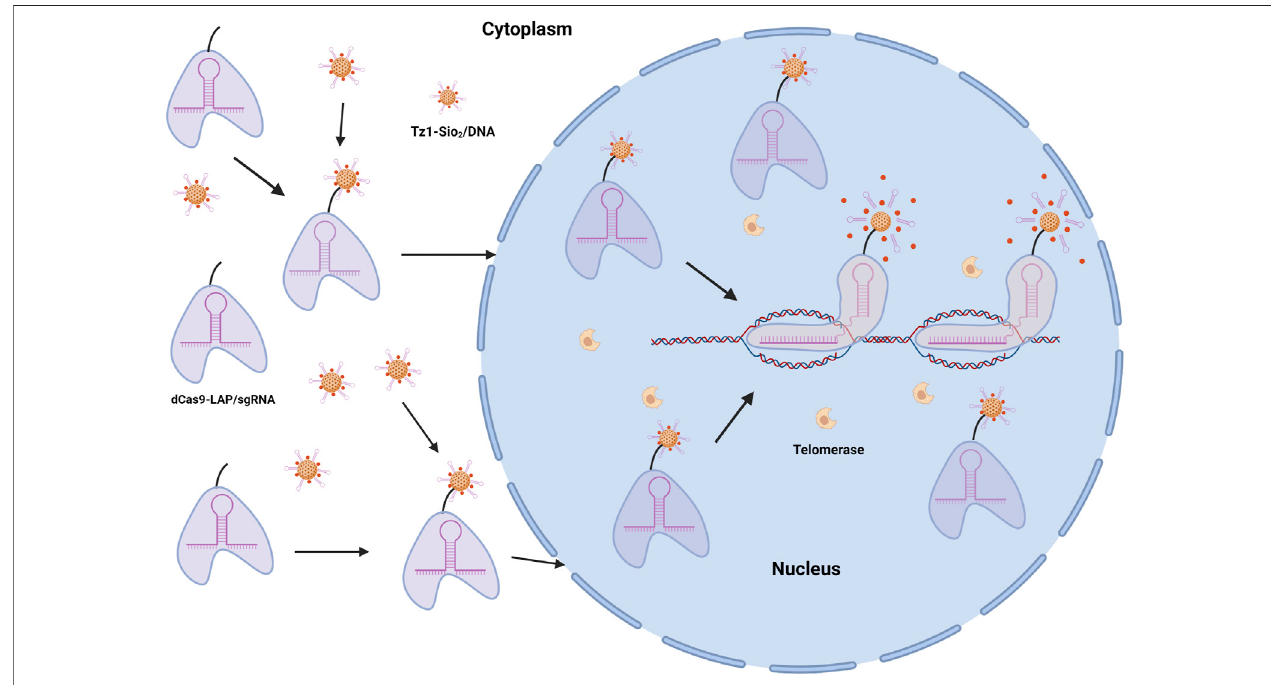
FIGURE 3 | dCas9-MSN/DOX/DNA drugs target cancer cell nucleus and release. DOX, the primary anticancer agent, is encapsulated in MSNs to produce the telomerase-responsive biogate (MSNs/DOX/DNA). In the presence of telomerase, which is extremely active in tumor cells but inert in normal healthy cells, the time of wrapping DNA can be